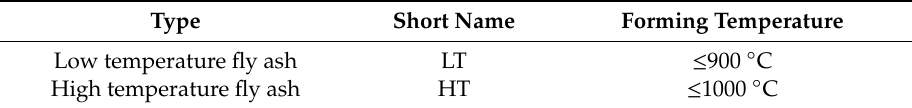
Table 4. Type of fly ash based on boiler operations.